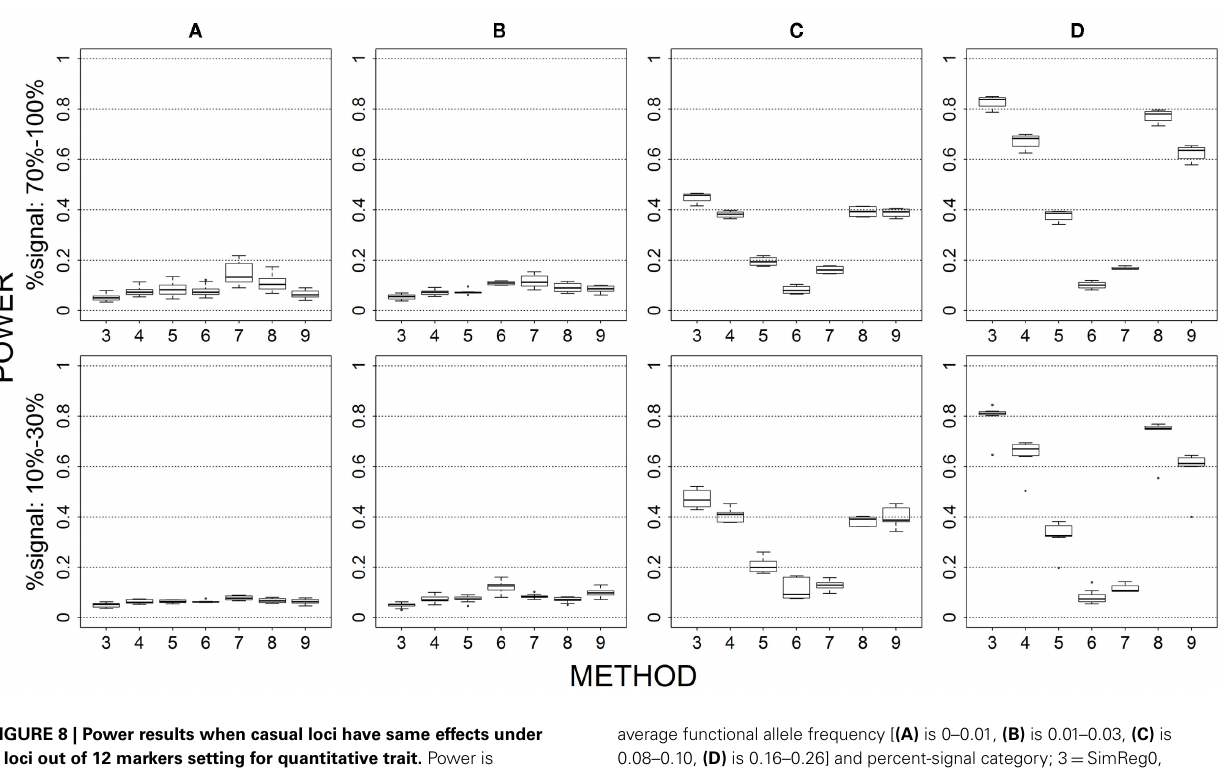
average functional allele frequency [ (A) is 0–0.01, (B) is 0.01–0.03, (C) is 0.08–0.10, (D) is 0.16–0.26] and percent-signal category; 3 = SimReg0, 4 = SimReg3, 5 = SimReg4, 6 = SKATsr, 7 = VT, 8 = 2Stage, 9 = MinP (Note: 1 = CMC01 and 2 = CMC05 are not applicable to quantitative